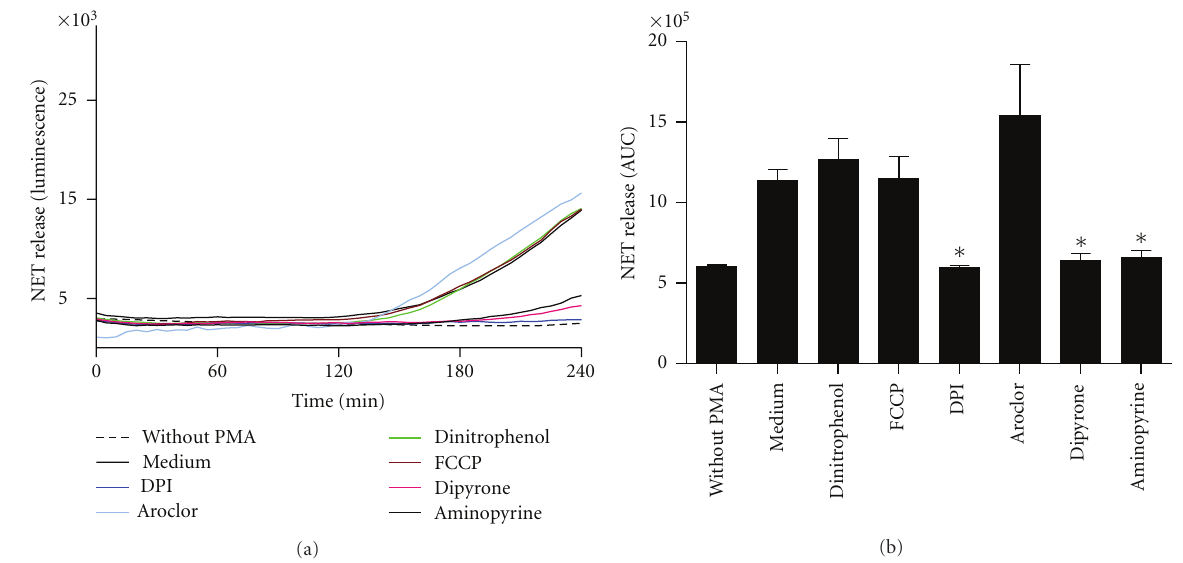
Figure 6: Release of NETs by neutrophils after exposure to various ROS inhibitors as measured by the SYTOXgreen assay. Freshly isolated human neutrophils were incubated with or without inhibitors (10 µ M Dinitrophenol, 500 nM FCCP, 20 µ M DPI, 38 µ M Aroclor, 200 µ M Dipyrone, and 200 µ M Aminopyrine) for 30min at 37 ◦ C. Subsequently, 5 µ M SYTOXgreen was added to all samples, and formation of NETs was induced by 20 nM PMA. Samples without PMA were used as control. The NET production was detected for a period of 4 h at 37 ◦ C by measuring the fluorescence of DNA-bound SYTOXgreen. (a) Time kinetics of NET release (fluorescence intensity) of one representative experiment. (b) Quantification of NET release by calculation of the area under the curve (AUC). Data show mean ± SD from three independent experiments, ∗ : P < 0 . 01 as compared to the PMA-stimulated sample without inhibitor